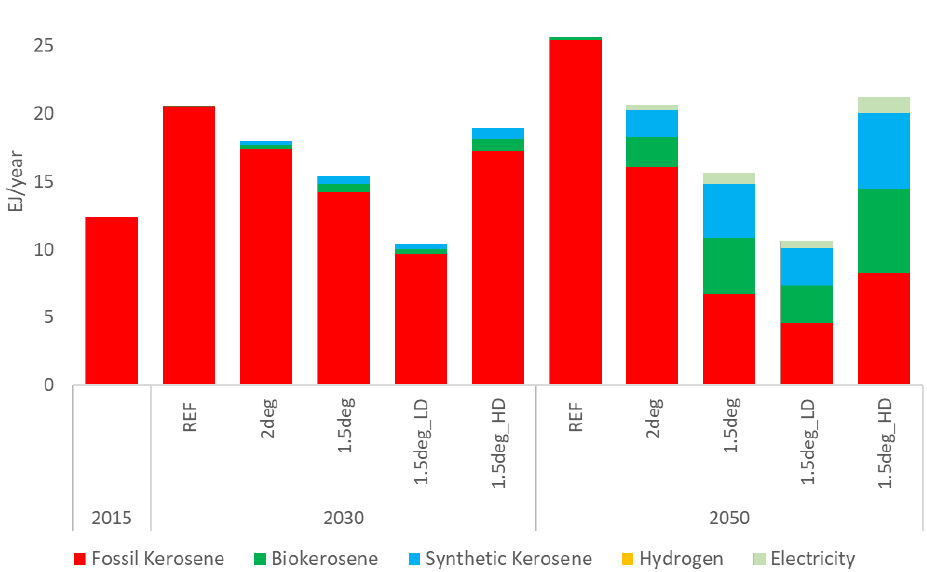
Figure 6. Global fuel consumption for aviation in alternative scenarios in 2030 and in 2050.